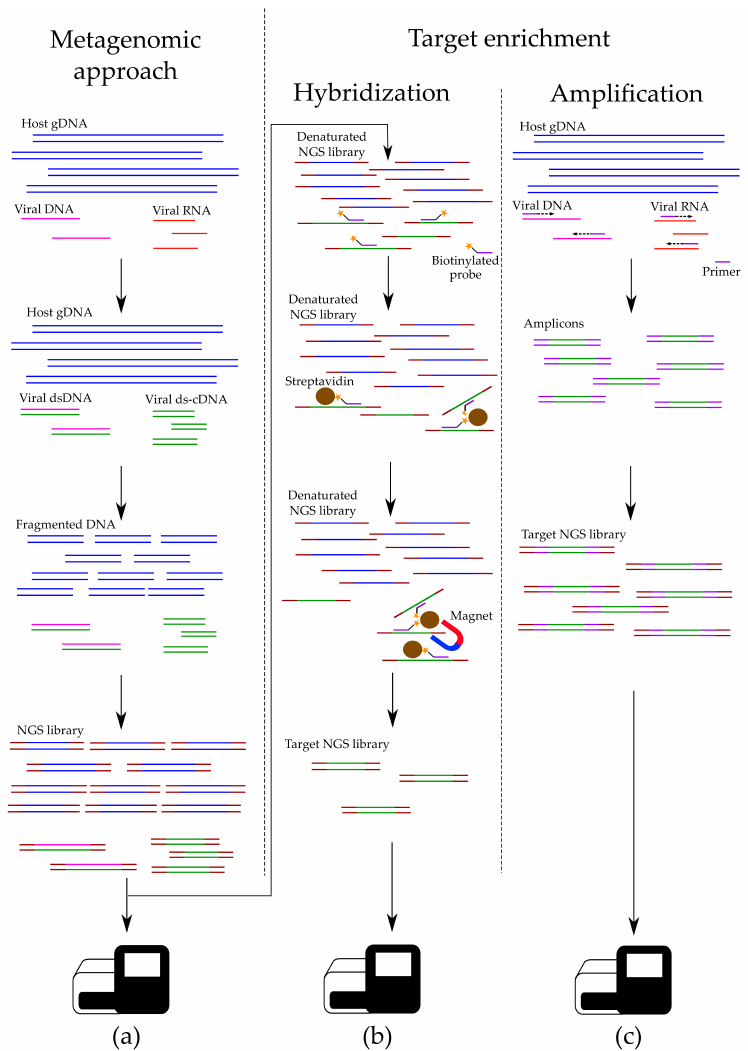
Figure 2. Unlike metagenomics ( a ), target HTS takes on an extra step of hybridization enrichment ( b ) and / or target amplification ( c ), during which the concentration of selected sequences is